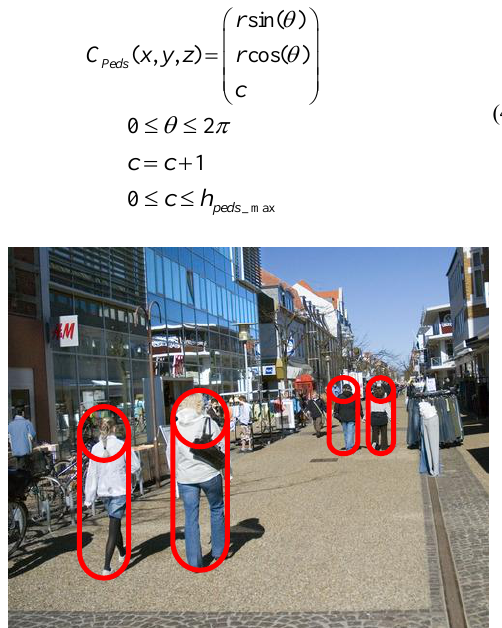
Figure 4. Modeling Pedestrians in Urban Scene Using Cylinders (Colored in